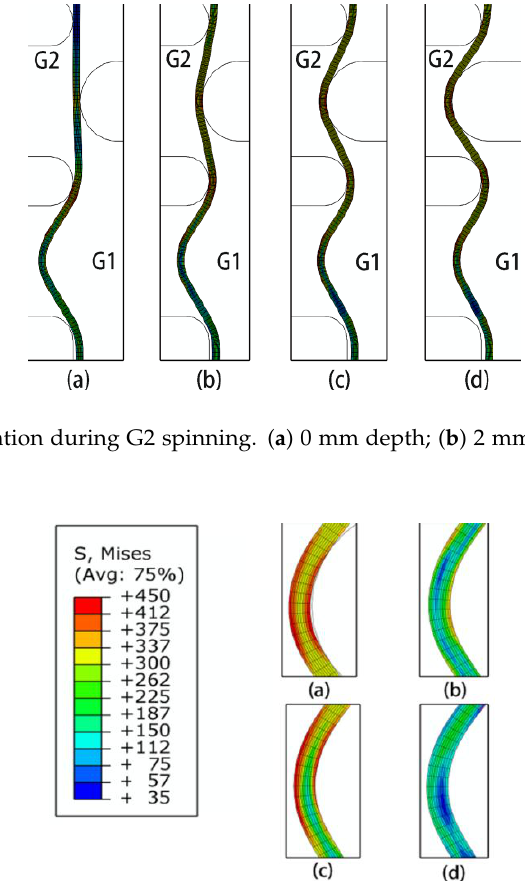
Figure 11. Stress variation of G1 bottom during spinning. ( a ) G1 spinning; ( b ) following G1 spinning; ( c ) G2 spinning; ( d ) following G2 spinning.